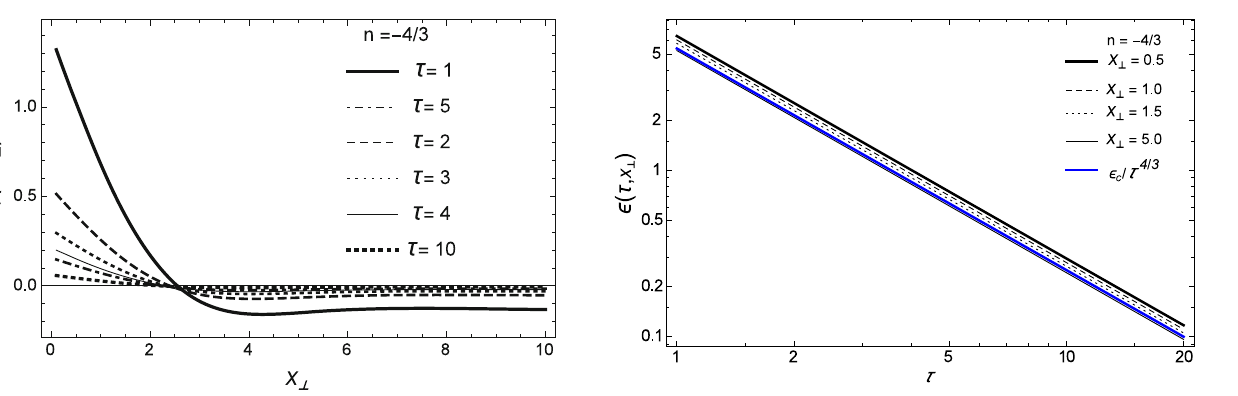
Fig. 15 (cid:5) 1 as a function of x ⊥ for different values of τ